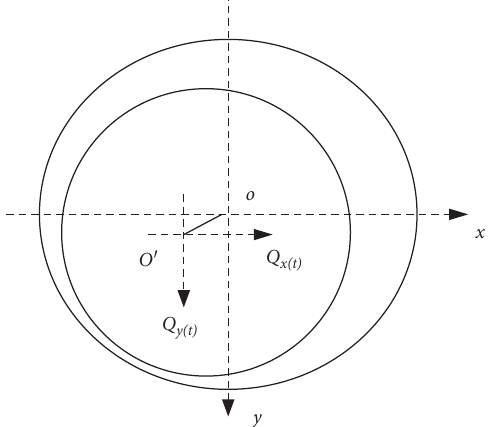
Figure 3: Mechanical model of rotor under dynamic